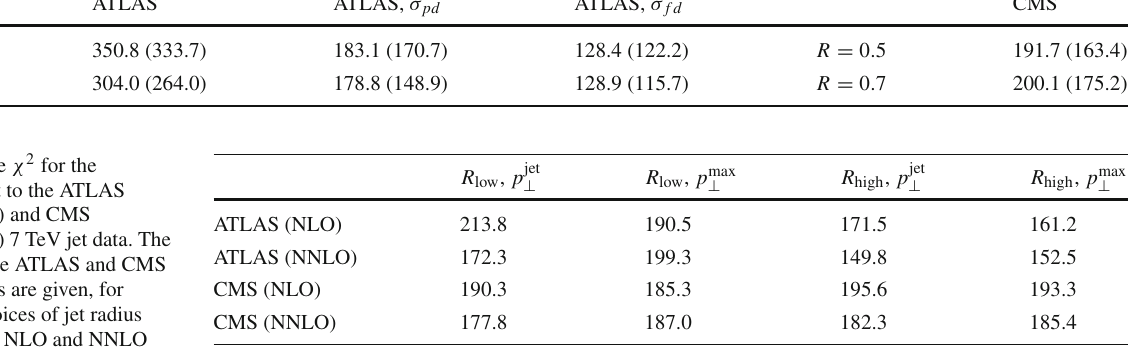
given in brackets. Results with the different treatments of the ATLAS systematic uncertainties, described in the text, are also shown